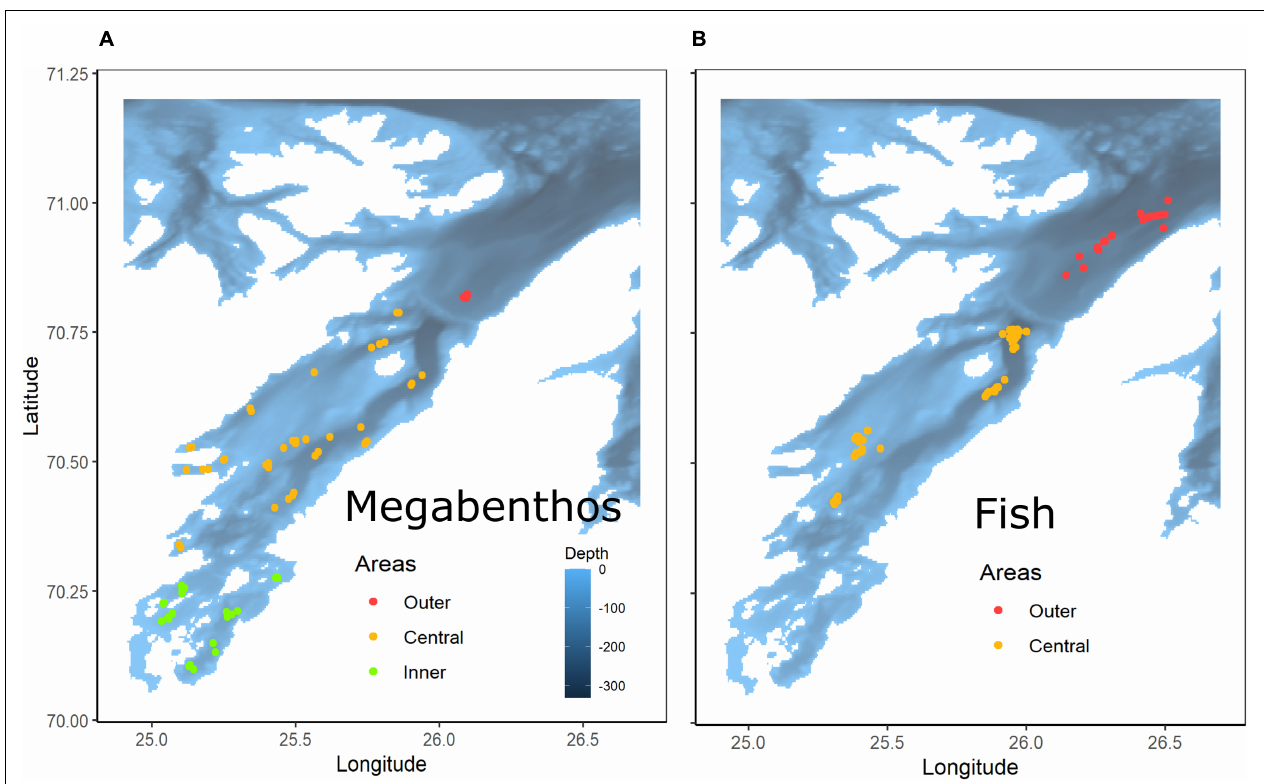
FIGURE 2 | Sampling sites for megabenthic taxa (A) and fish taxa (B) in the inner (green), central (yellow), and outer (red) parts of the fjord.